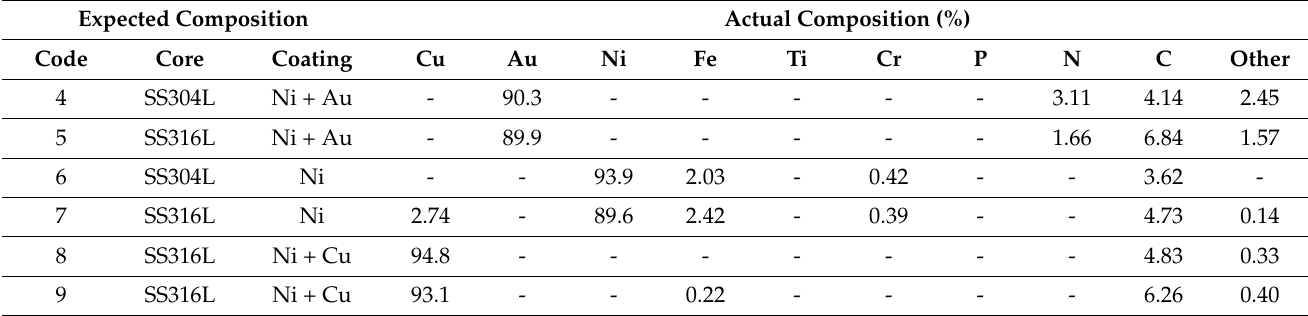
Table 8. External surface EDX compositions from box scans of identified contamination zones.